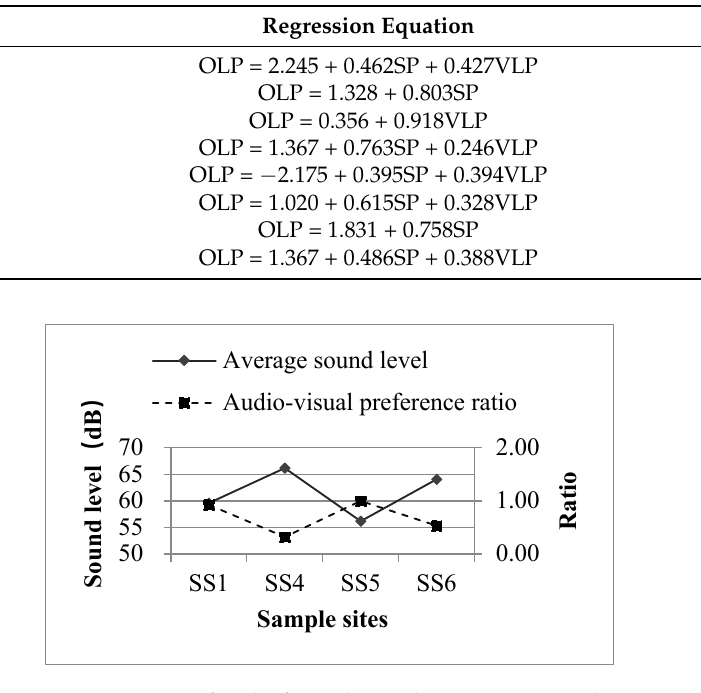
Figure 5. Ratio of audio/visual contribution to OLP and average sound level.